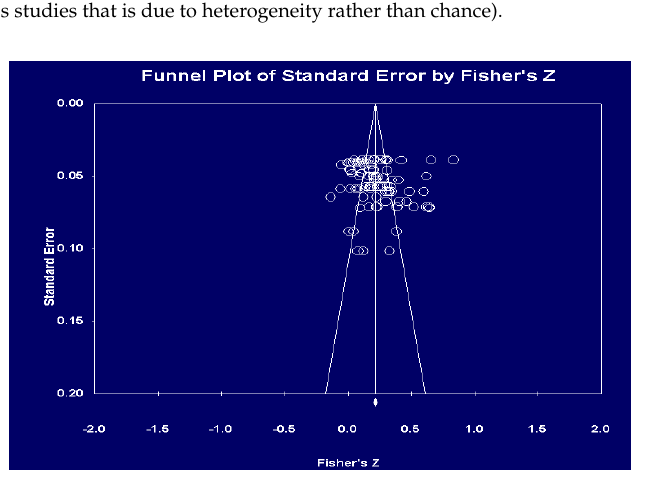
Figure 3. Funnel Figure 3. Funnel plot.